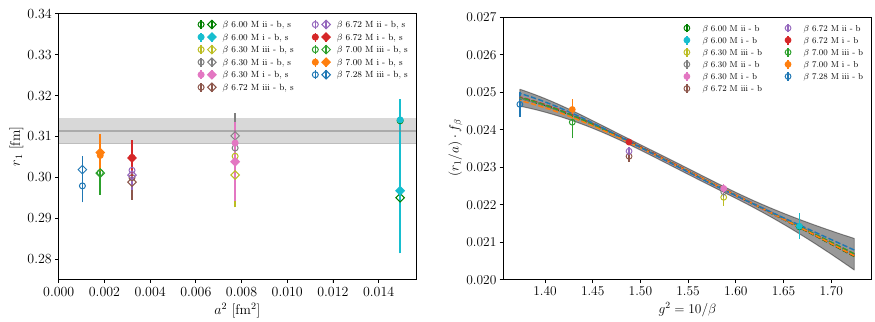
Figure 1. The scale r 1 for all ensembles (colors) and bare ( ◦ ) and smeared ( ⋄ ) gauge links. Left: We use the lattice scale a f to convert to physical units and as an x -axis. The gray p 4 s band indicates the (2 + 1)-flavor value from FLAG 2021 [17]. Right: The scale multiplied by the two-loop β -function. The curves indicate the Allton fit (3), evaluated at the physical mass. The color of the lines indicates the ensemble that has been left out, while the black curve includes all